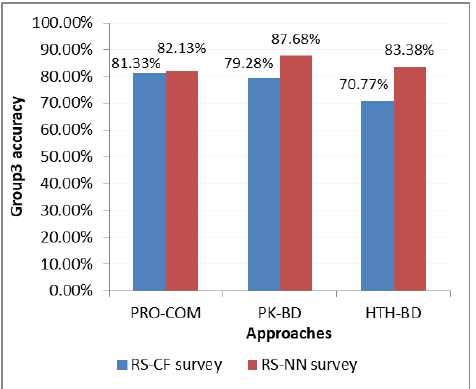
Figure 7. Comparative study using accuracy considering group 3.